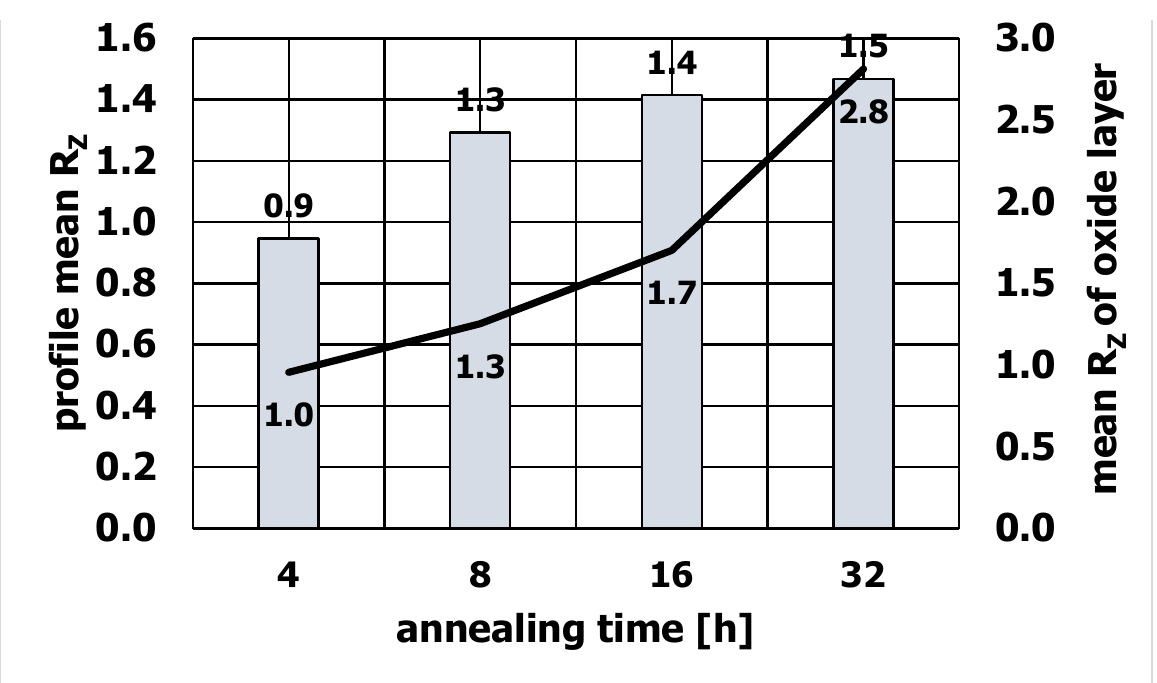
Figure 11. Roughness of extruded aluminum profiles and the oxide deposited on the die.